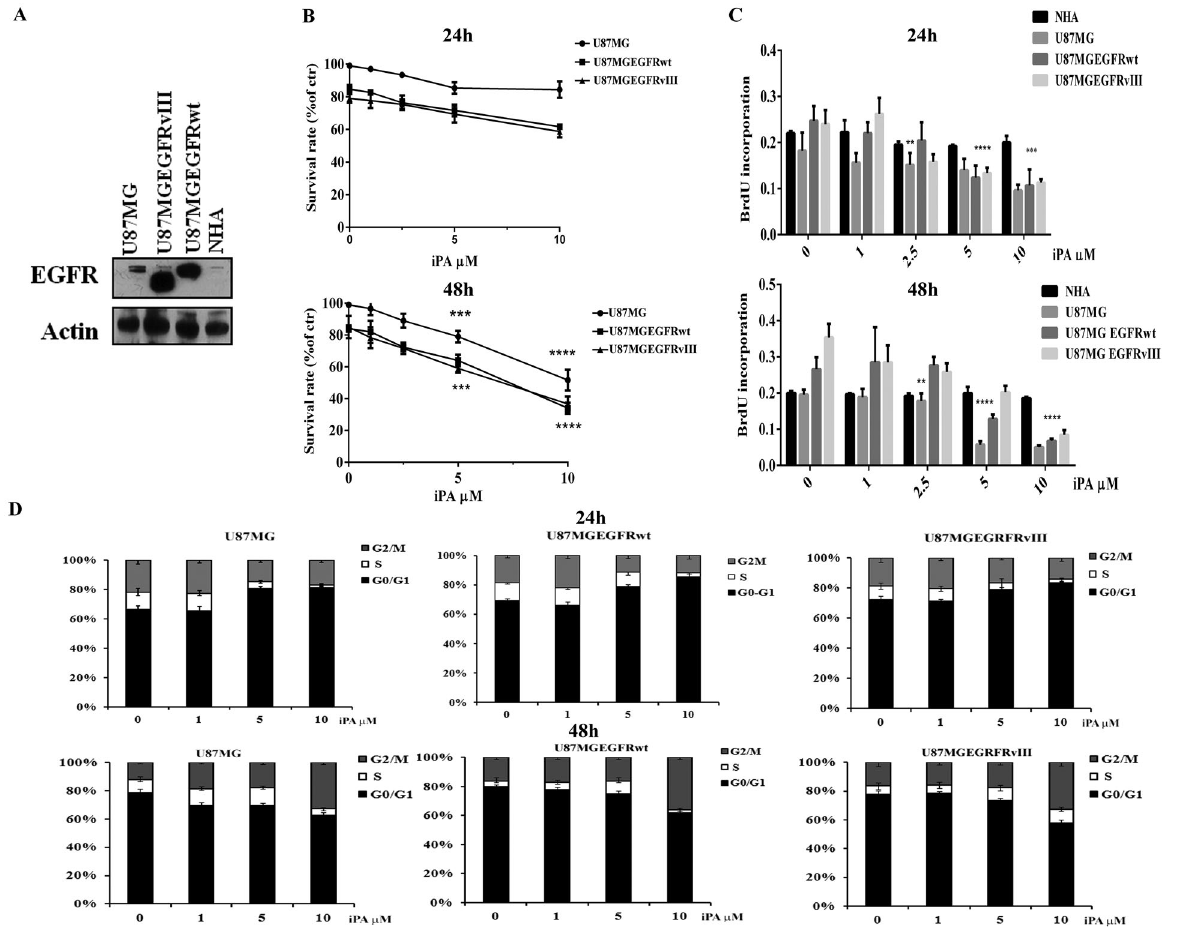
Fig. 1 Antiproliferative effect of iPA in GBM cells. A Western Blot assay showing the different expression levels of EGFR in U87MG, U87 EGFRvIII, U87 EGFRwt, and NHA cell lines. B Graphic representation of results from MTT assays to determine cell viability of U87MG, U87EGFRvIII, and U87EGFRwt treated with different concentrations (0 – 10 µM) of iPA for 24 h and 48 h. C Antiproliferative effect of iPA on U87MG, U87 EGFRvIII, U87 EGFRwt GBM cell lines, and NHA cells as detected by BrdU assay after 24 h and 48 h of treatment. D Graphic representation of cell cycle distribution obtained using PI staining and fl ow cytometry. Data points are the percentage of cells in G0/1, S, and G2/M in U87MG at 24 h and 48 h after iPA treatment. The data are presented as mean ± SD of at least three independent experiments. ** p < 0.01, *** p < 0.001, **** p < 0.0001 versus control, represented by cells treated with vehicle